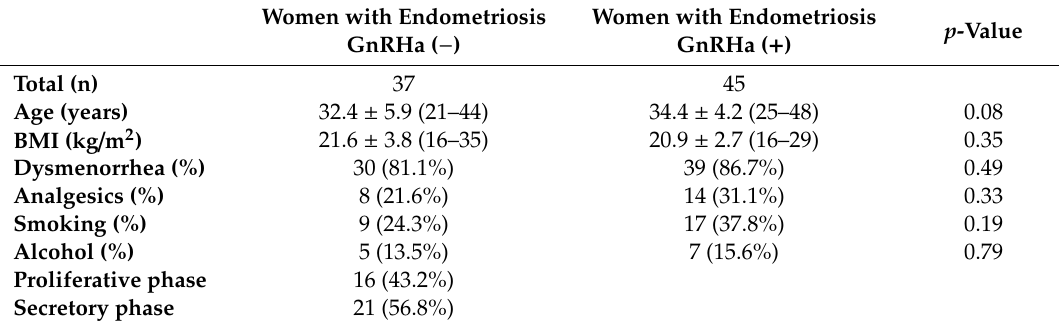
Table 1. Baseline characteristics of the study population.